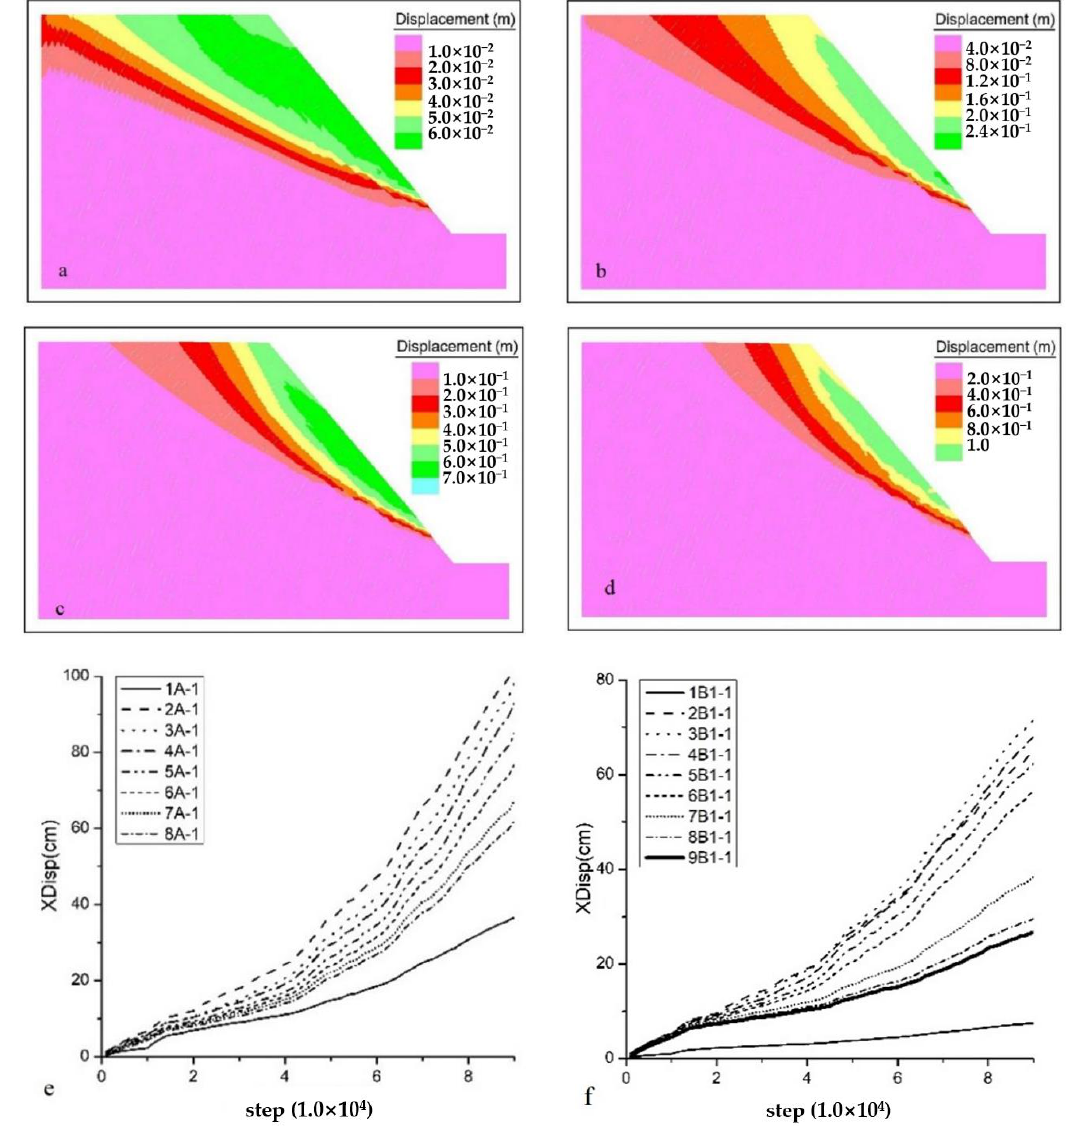
Figure 8. ( a ) The total displacement of slope before water storage. ( b ) The total displacement of slope when the reservoir impounded 30 m. ( c ) The total displacement of slope when the reservoir impounded 60 m. ( d ) The total displacement of slope when the reservoir impounded 80 m. ( e ) The displacement in X direction of series monitoring points in area A. ( f ) The displacement in X direction of series monitoring points in area B.